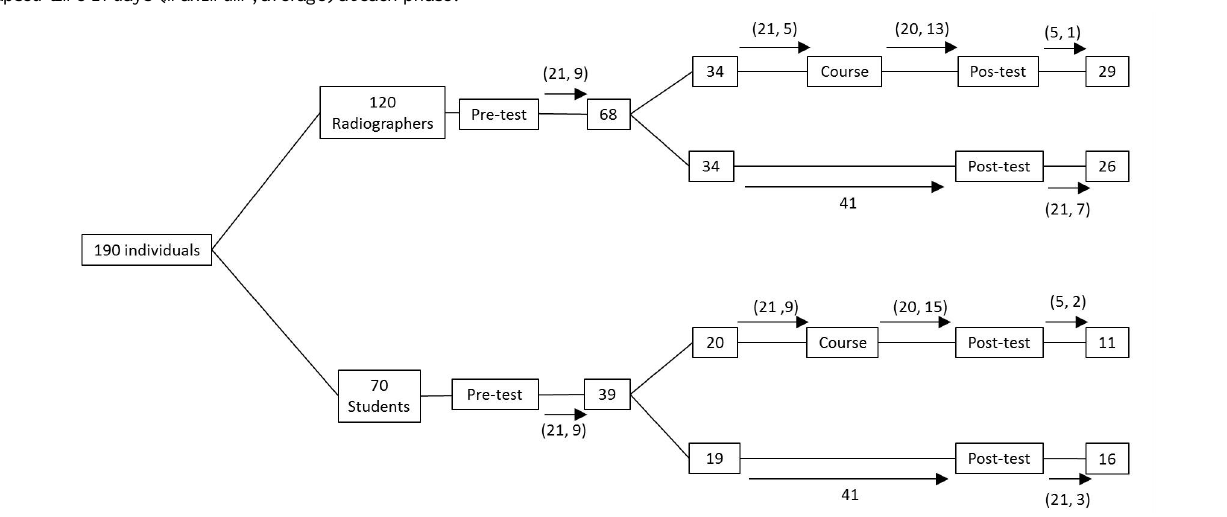
Figure 1. Study design and post-implementation duration: numbers in boxes represent number of participants; numbers in arrows correspond to the elapsed time in days (maximum, average) at each